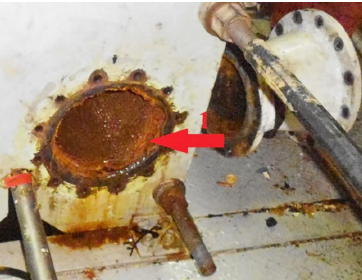
Figure 10. Container ship MERWE TRADER with the summer DeadWeight Tonnage (DWT) of 11842 tons